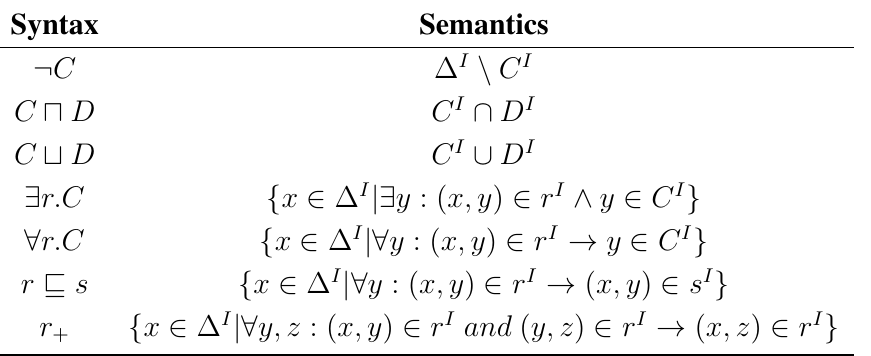
Table 1. Syntax and Semantics of SH